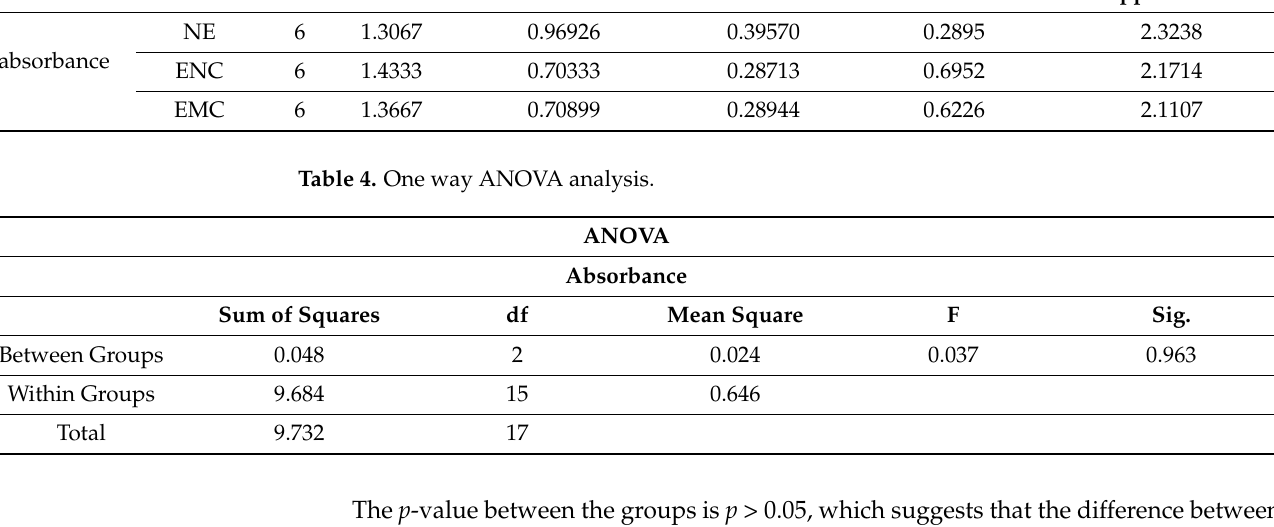
Table 4. One way ANOVA analysis.